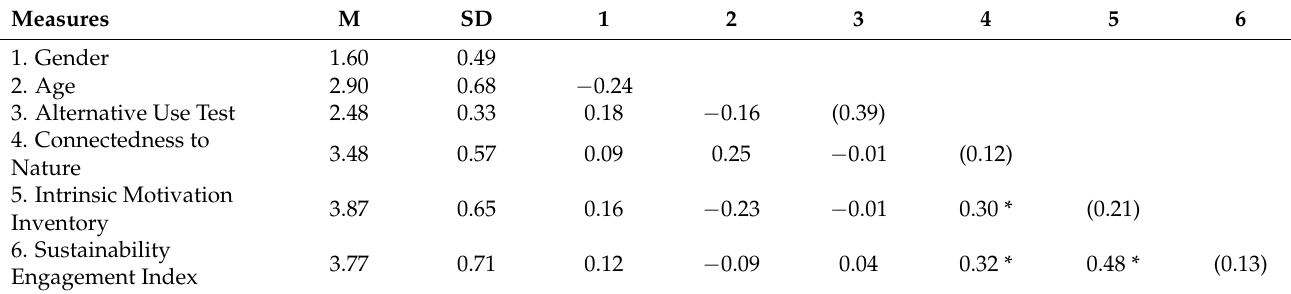
Table 7. Means, standard deviations, and Pearson correlation